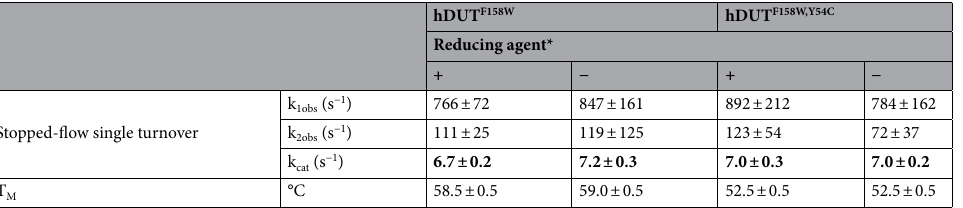
Table 1. Enzymatic parameters of hDUT F158W and the hDUT F158W,Y54C in the presence and absence of reducing agent (Kinetic data represent the average and standard deviation of 3–5 measurements, T M data represent the average and standard deviation of 3 parallels). *10 mM